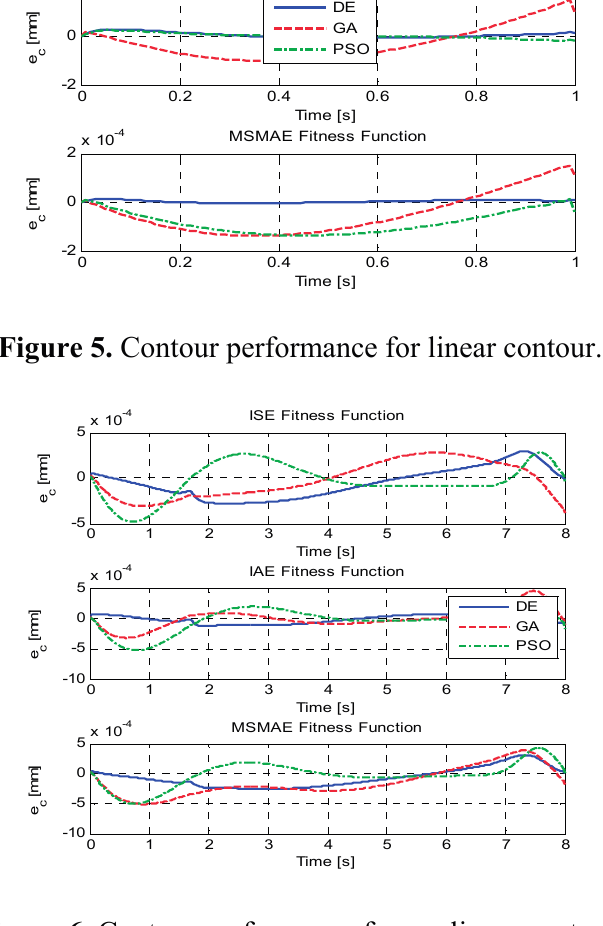
Figure 6. Contour performance for nonlinear contour.